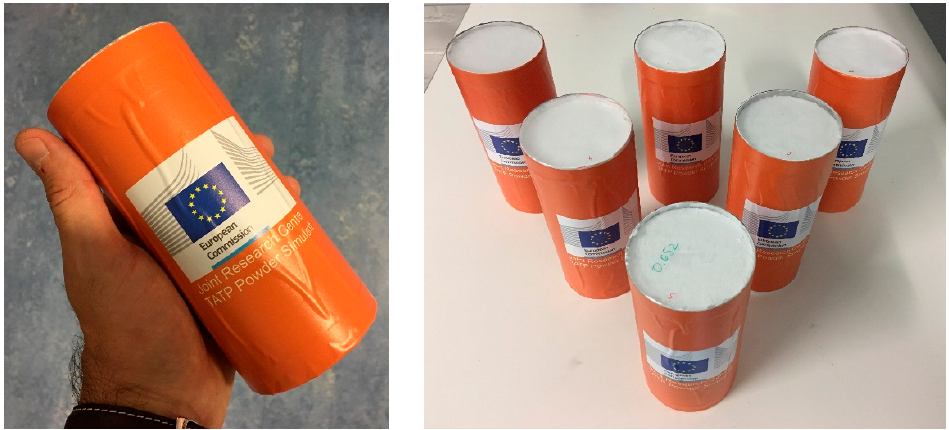
Figure 2. Photos of our TATP simulant based on stearates, caffeine and benzoates.